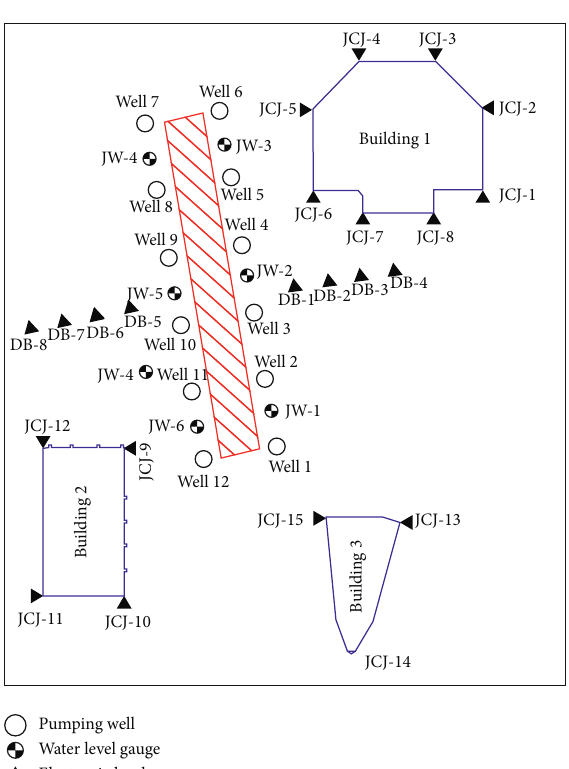
Figure 3: Monitoring point layout map.